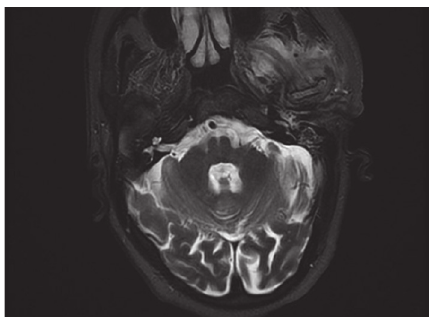
Figure 2: T2-weighted axial MRI prior to treatment being commenced for NOE again demonstrating inflammatory changes centred around the left temporomandibular